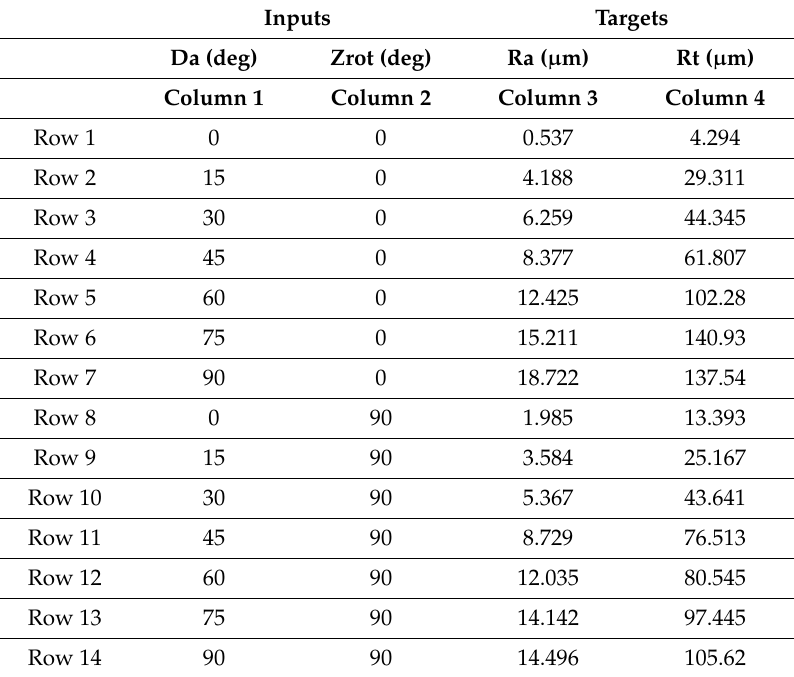
Table 2. Inputs and targets for the NN modeling.